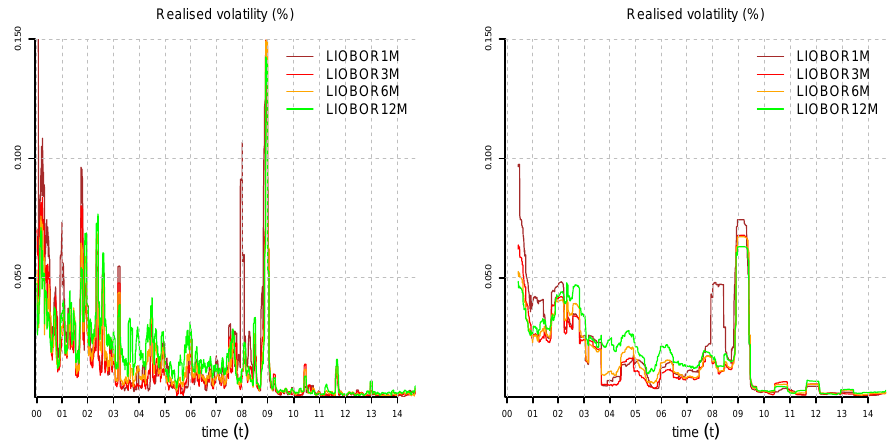
(cid:92) RCov ( t , τ , τ ) 1 2 for τ = 21,63,126,252, window length K = 21 (lhs)